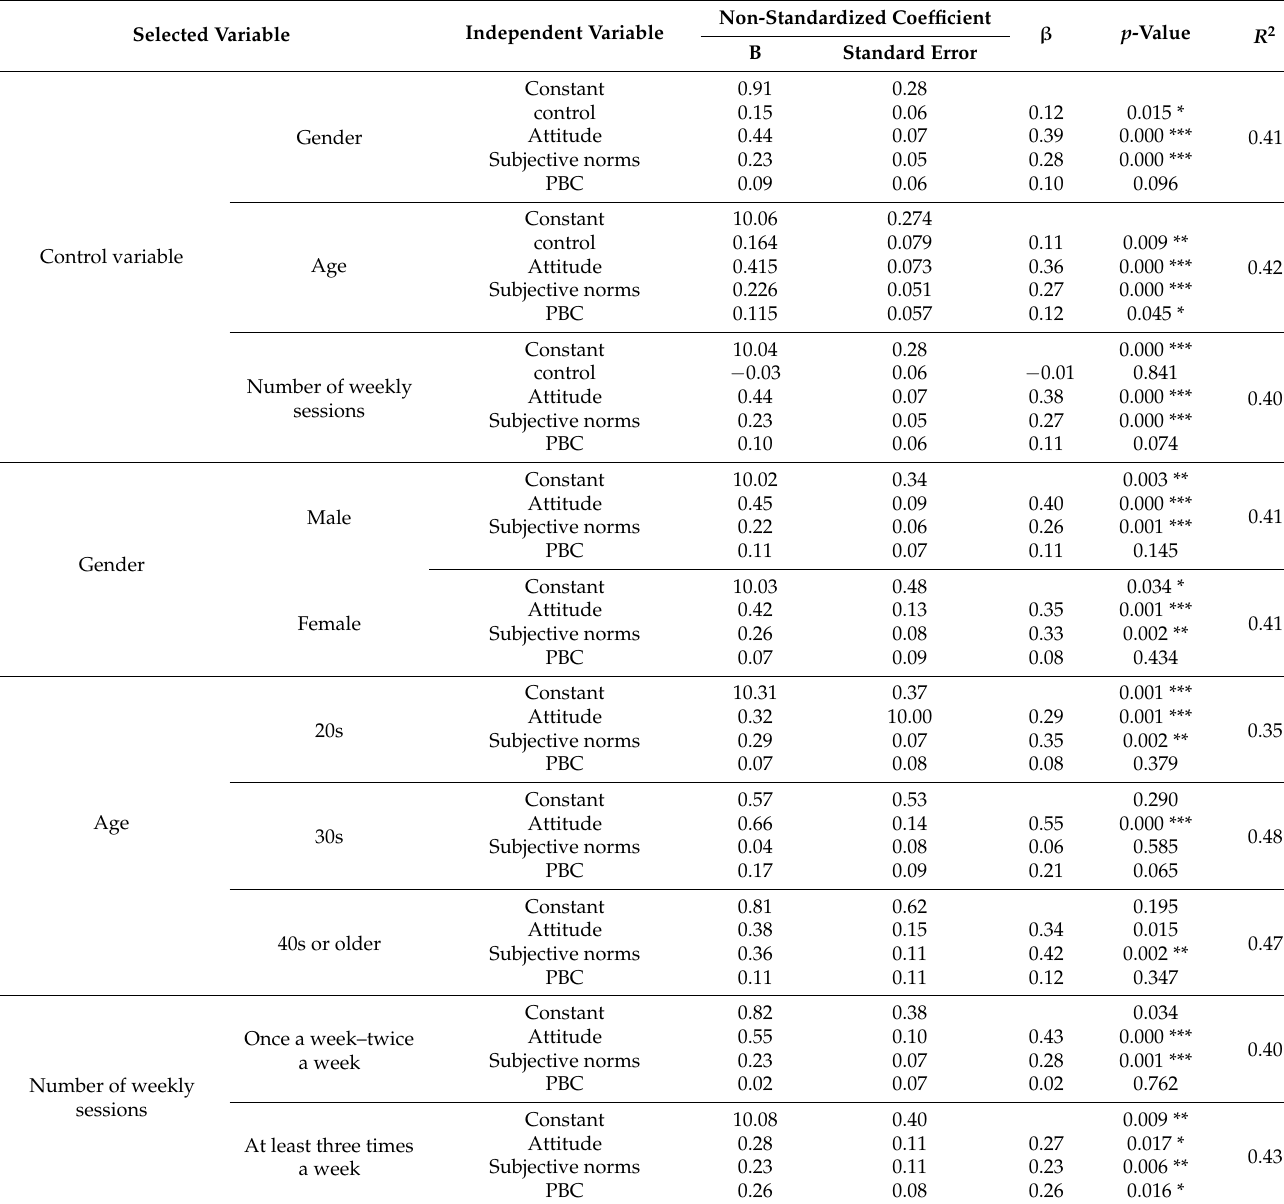
Table 5. Effects of TPB factors on intention based on demographic characteristics of fencing club members ( n = 233). Selected